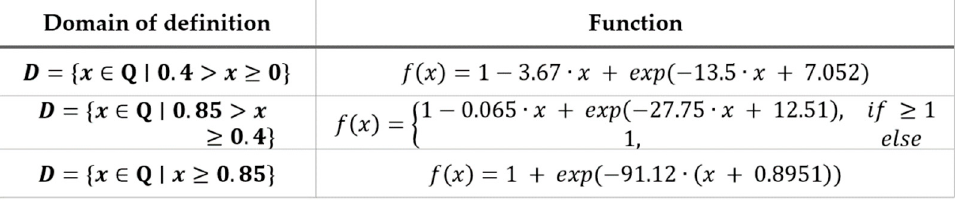
Figure 12. Partial functions for the generation of the degradation curve for an FC. Table 1. Sampling points for the generation of the degradation curve for an FC.